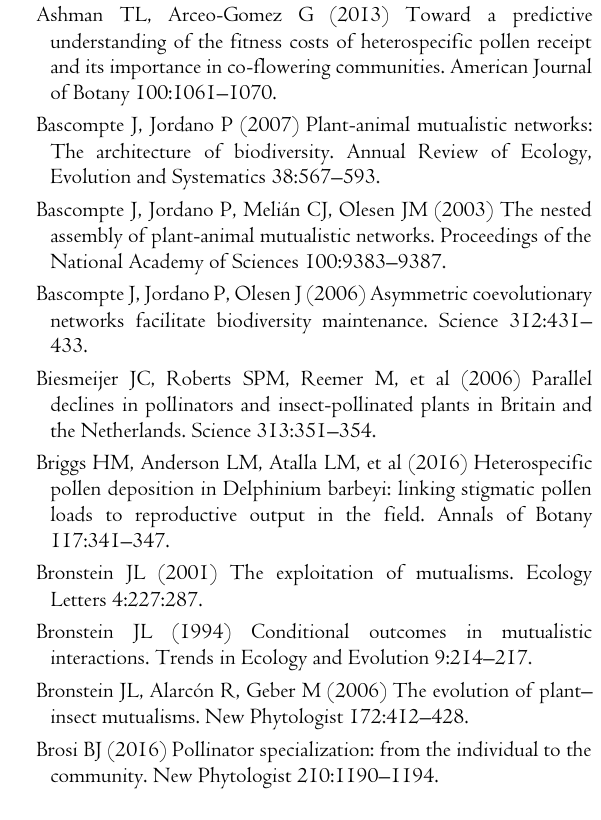
F IGURE 3. Effects of negative interactions on total number of extinction cascades occurring during pollinator knockout simulations for different extinction orders and starting networks. Points indicate the mean total number of cascades summed across an entire knockout sequence for 50 extinction simulations. Error bars indicate ± 95% confidence intervals. Total cascades are presented for each proportion negative interaction across three simulated extinction orders (row headers) and starting network IDs (column